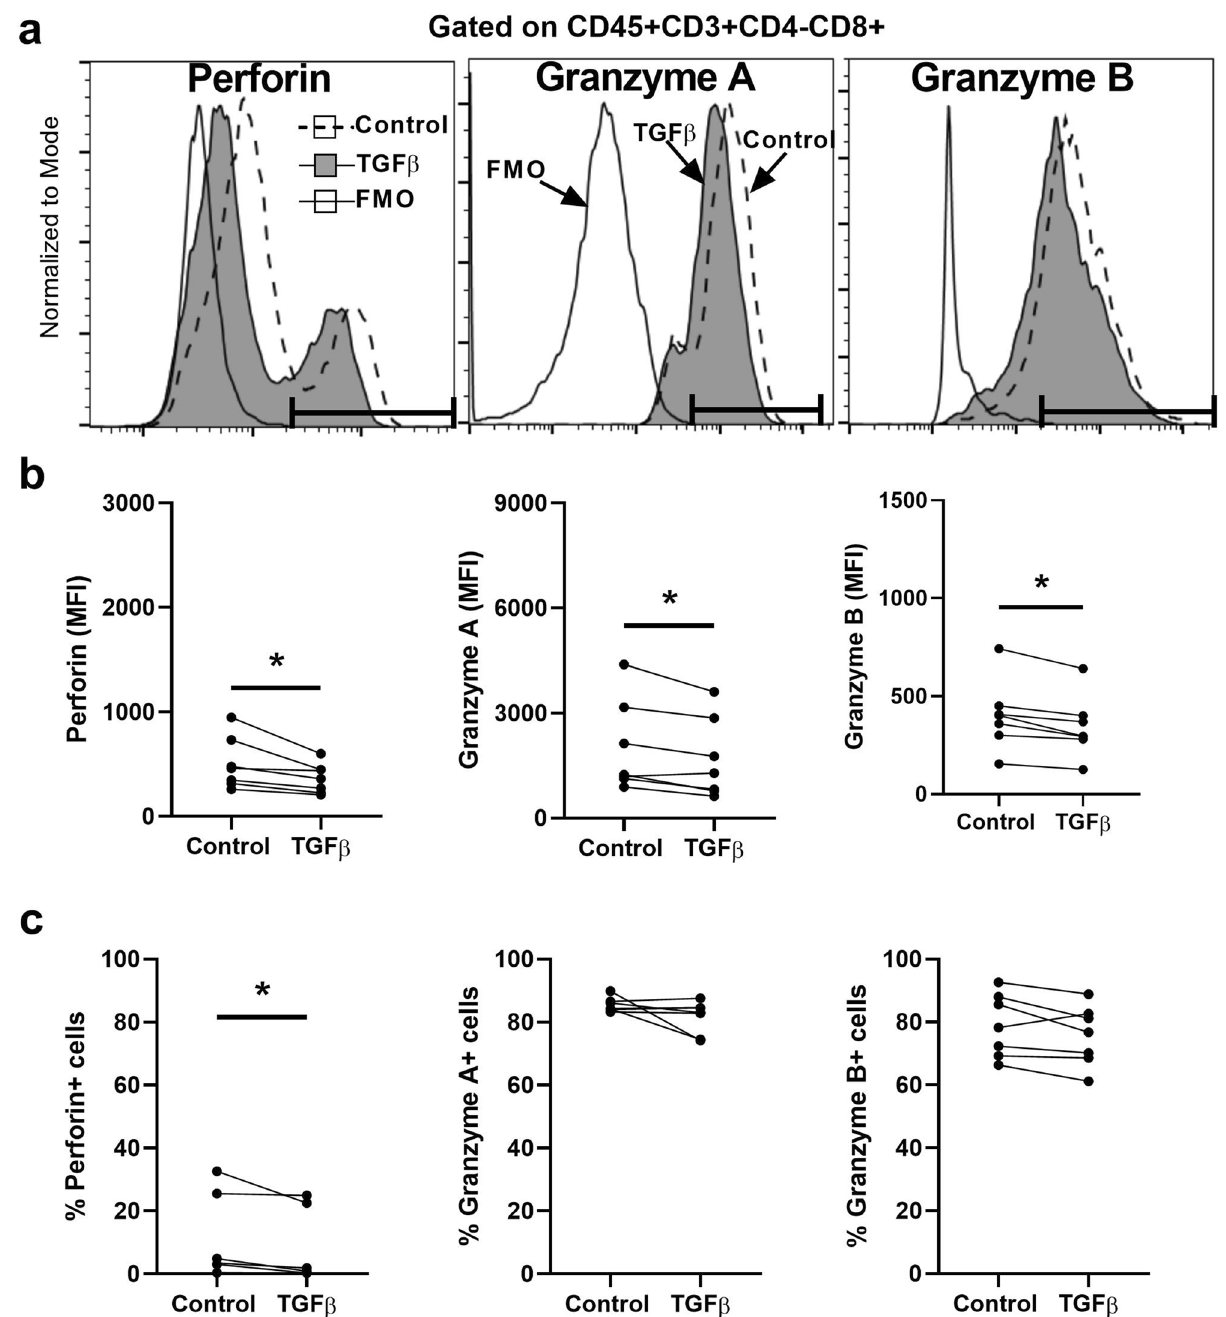
Figure 4. Effect of TGFβ on intracellular cytotoxic molecules in endometrial CD8+T cells. Mixed cell suspensions from endometrial tissues were pre-treated with TGFβ (10 ng/ml) for 48 h and stained for the intracellular cytotoxic molecules perforin, granzyme A and granzyme B for analysis by flow cytometry. ( a ) Representative histograms of intracellular perforin (left), granzyme A (middle) and granzyme B (right) expression in endometrial CD8+T cells treated with TGFβ. Gate boundaries (horizontal line) were set by fluorescence minus one (FMO) to indicate the gating of positive cells. ( b ) Median fluorescence intensity (MFI) of perforin (left), granzyme A (middle), granzyme B (right) and ( c ) percentage of perforin+ (left), granzyme A+ (middle), granzyme B+ (right) in endometrial CD8+T cells following incubation with TGFβ. Each dot represents a different patient (n = 7). * P < 0.05, Wilcoxon matched-pairs signed rank